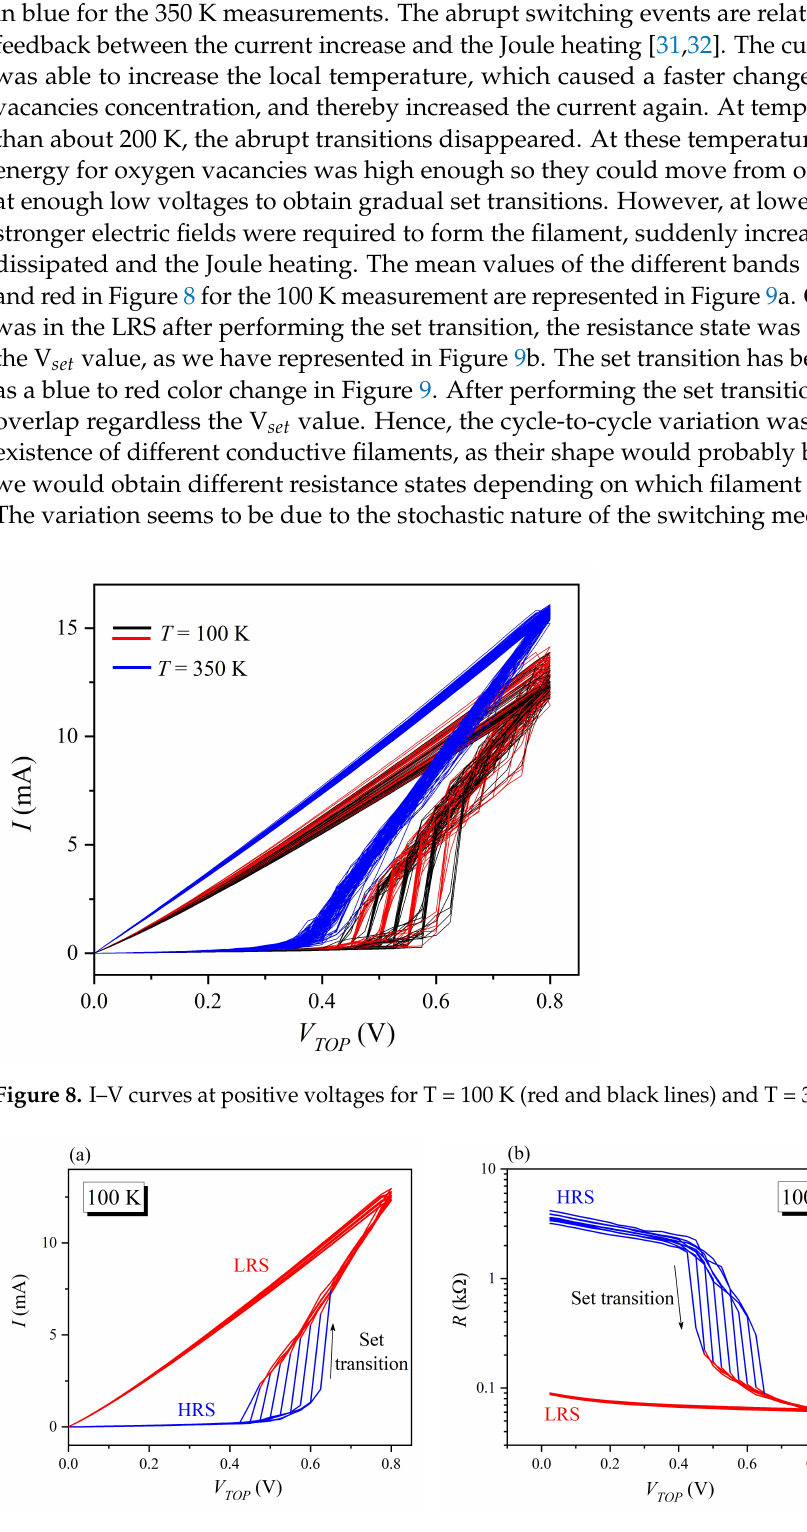
Figure 9. Mean values of the different bands for the I–V characteristic measured at 100 K ( a ) and the R–V characteristic at 100 K obtained from the mean values of the bands ( b